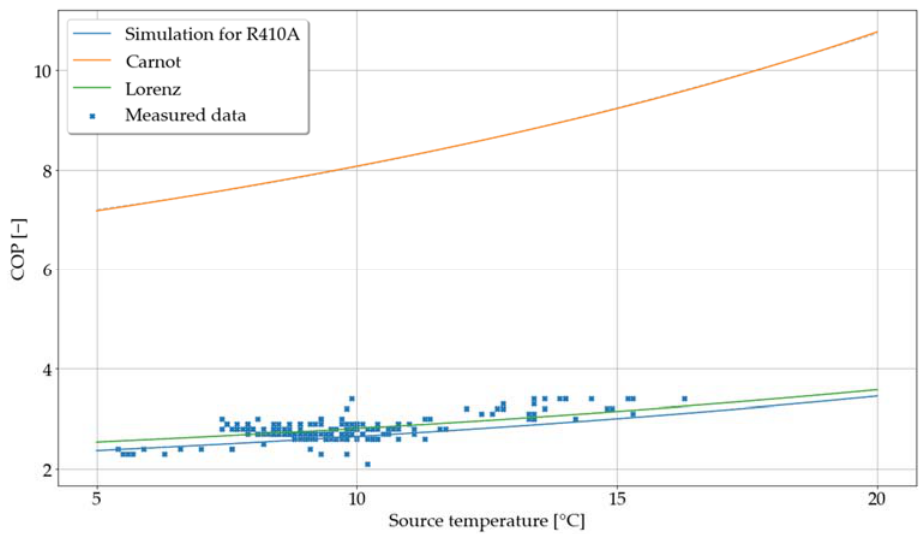
Figure 8. COP results for sink temperature = 50 °C.